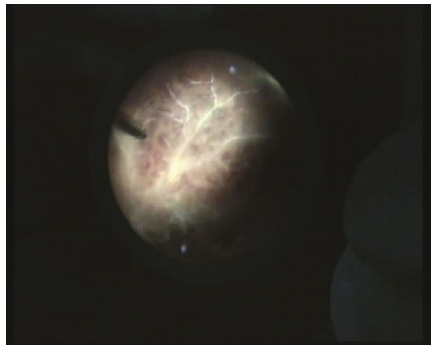
Figure 2: Septic retinal vasculitis and